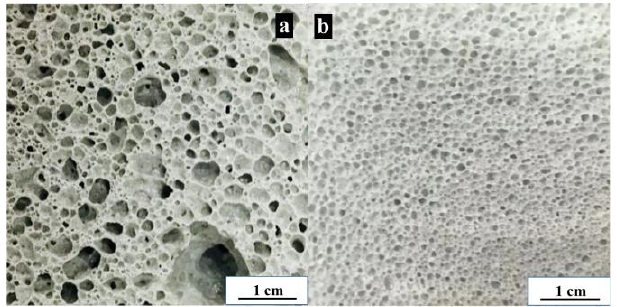
Figure 5. Sectional view of the S0 ( a ) dry-milled and ( b ) wet-milled samples.